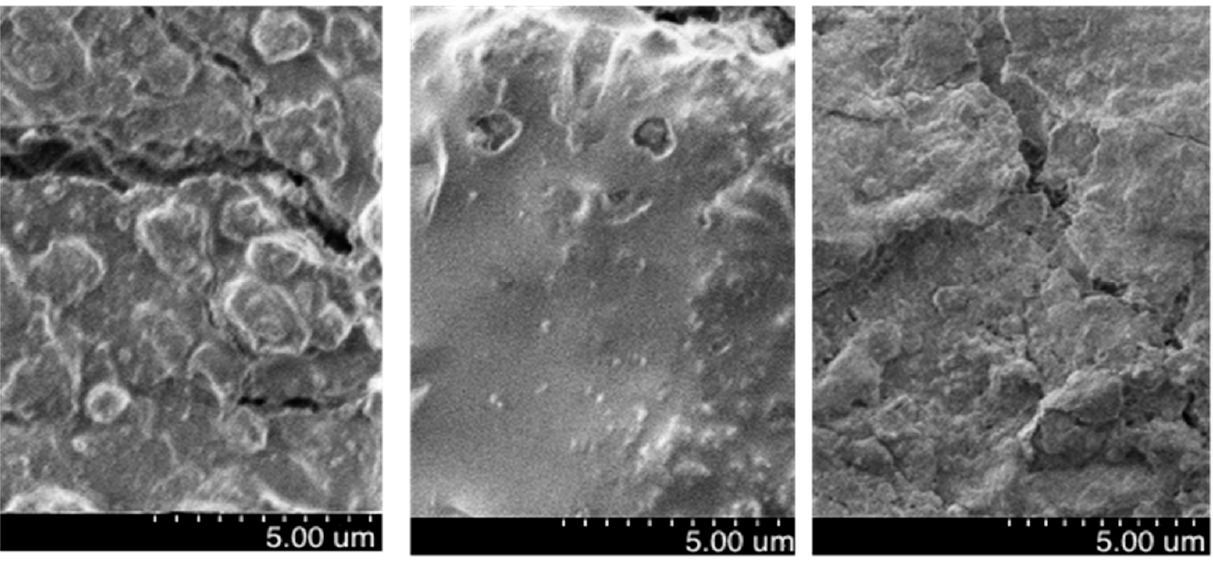
Figure 6. SEM images of green, red and blue colored samples (from left to right).